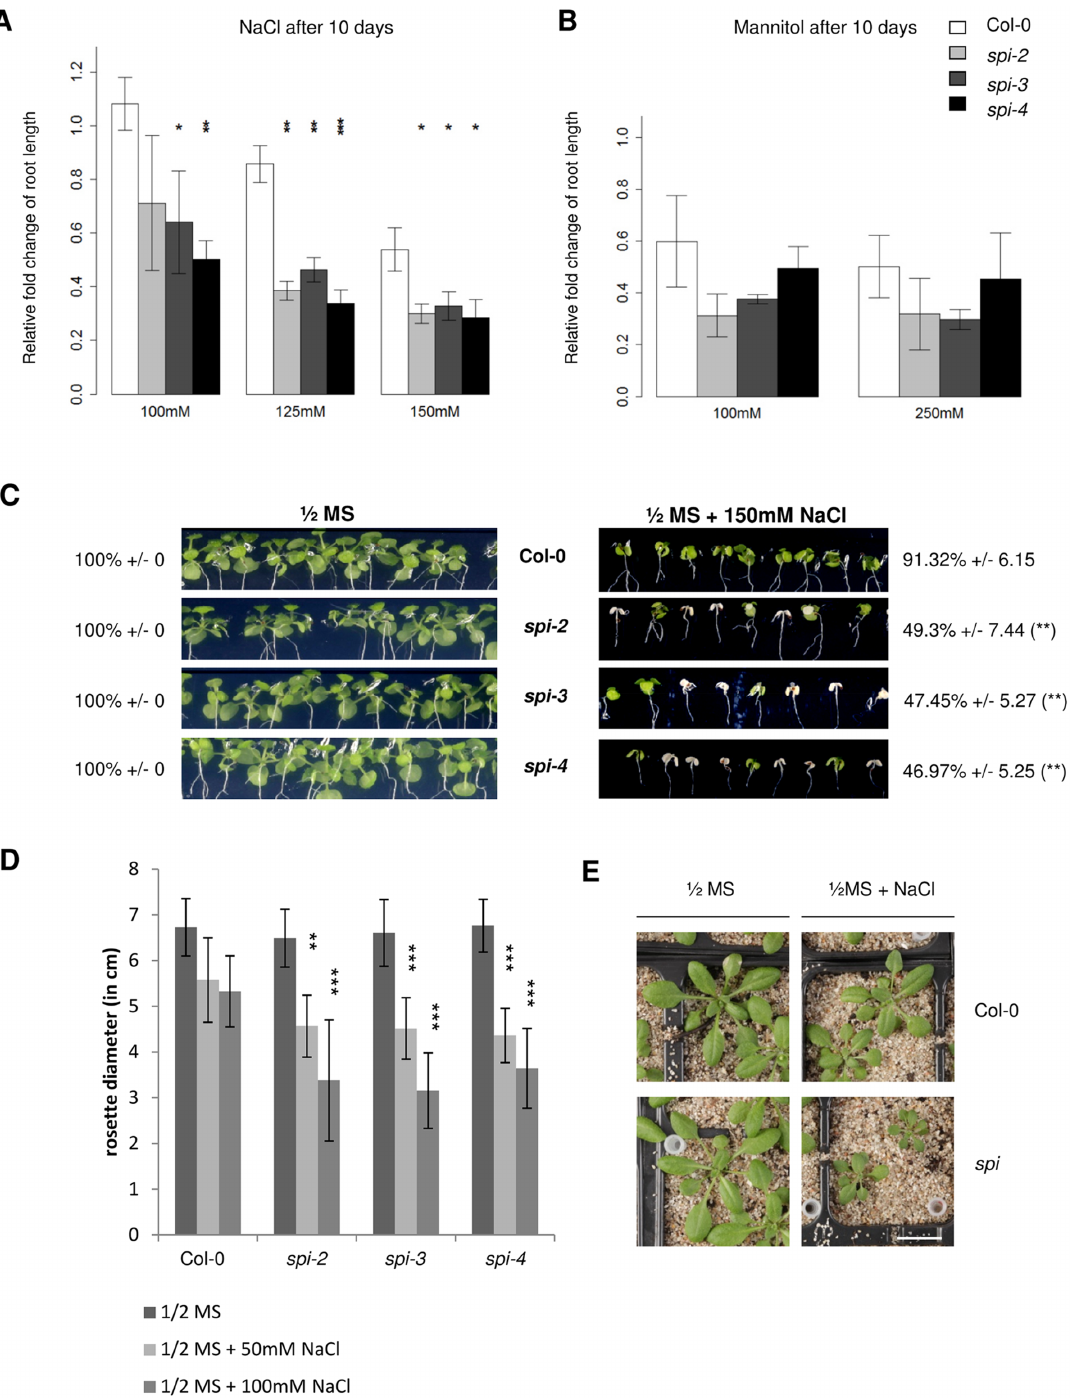
Fig 5. spi mutants display salt hypersensitivity. Relative changes of root length after 10 d on ½ MS plates supplemented with (A) 100 mM, 125 mM, and 150 mM NaCl or (B) 100 mM and 250 mM Mannitol (Man). Data in (A) and (B) were normalized to nonstress conditions and denote the average from three independent biological replicates ( n = 12 seedlings each). Error bars represent standard deviations. Two-tailed student ’ s t tests were performed to compare spi alleles and Col-0 exposed to the same conditions ( * p < 0.05; ** p < 0.01; *** p < 0.001). (C) Cotyledon greening of seedlings measured after 14 d on ½ MS plates supplemented with 150 mM NaCl. Greening efficiencies (in %) denote the average from three independent biological replicates ( n = 12 seedlings each). Errors represent standard deviations. Two-tailed student ’ s t tests were performed to compare spi alleles and Col-0 exposed to the same conditions ( * p < 0.05; ** p < 0.01; *** p < 0.001). (D) Diameter of leaf rosettes (in cm) of 32-day-old plants, measured after irrigation with ½ MS only (control) or ½